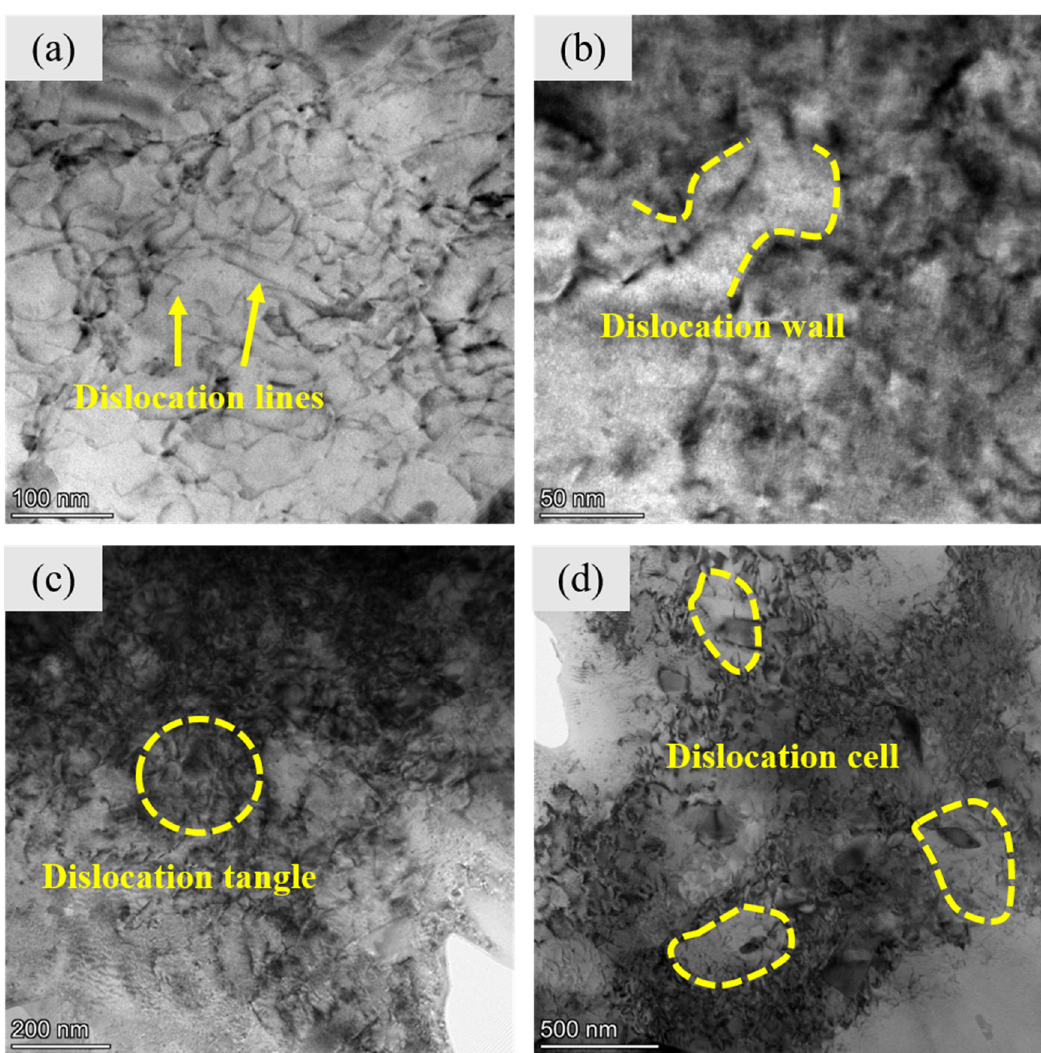
Figure 6. TEM images of the microstructure at a 50-depth after the 0.5_CWJP. ( a ) Dislocation lines; ( b ) dislocation walls; ( c ) dislocation tangles; ( d ) dislocation cells.